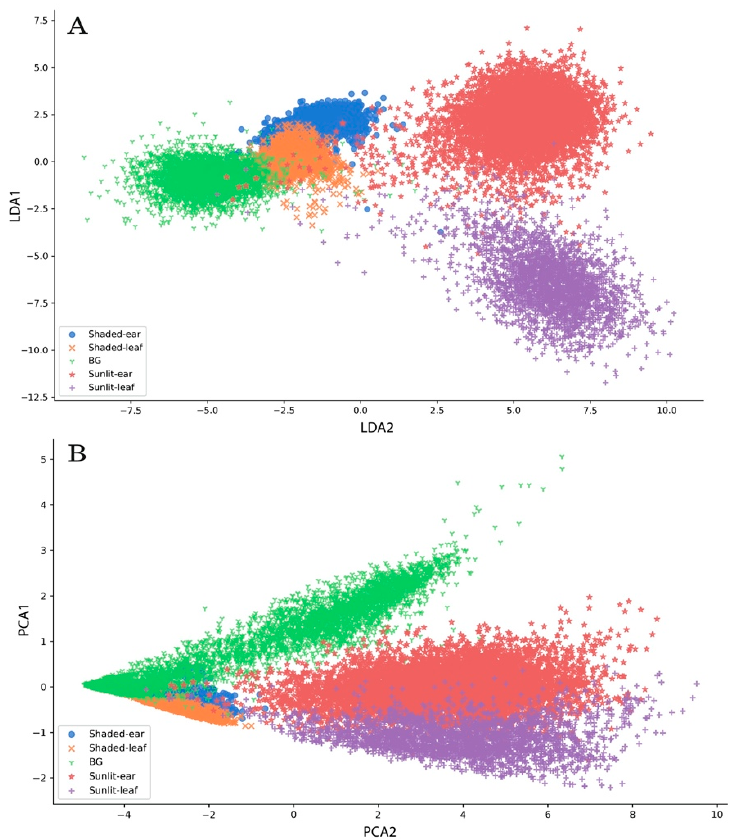
Figure 2. Scores scatter plots of the first and second LDA and PCAs. ( A ) shows the LDA analysis and ( B ) demonstrate the PCA analysis of 5 categories of shaded-ear (SHE), shaded-leaf (SHL), sunlit-ear (SE), sunlit-leaf (SL), and background (BG).